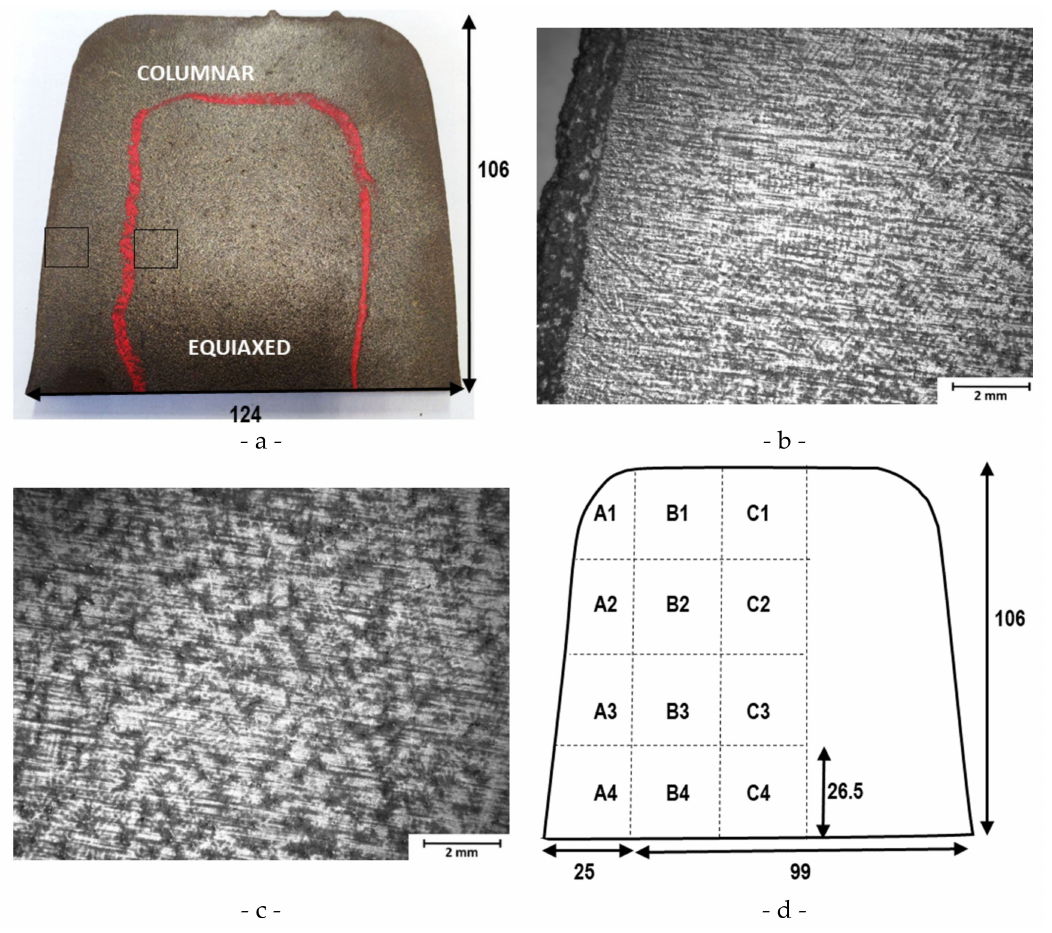
Figure 3. ( a ) Ingot cross section prior to normalization treatment. Red: boundary between columnar and equiaxed the black squares correspond to the zooms presented in figures ( b , c ). ( b ) Columnar zone, ( c ) equiaxed zone. ( d ) Sample cutting localization and labels for microstructure analyzes on an ingot after normalizing heat